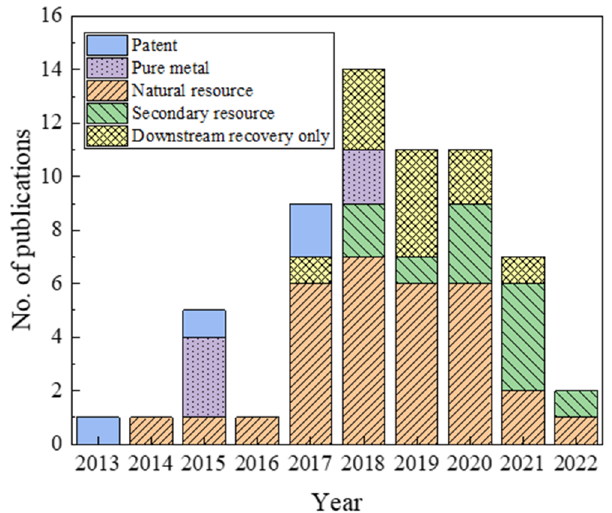
Figure 1. Number of publications regarding glycine leaching systems used to treat different solid resources since 2013 (data for 2022 is up to March 2022).